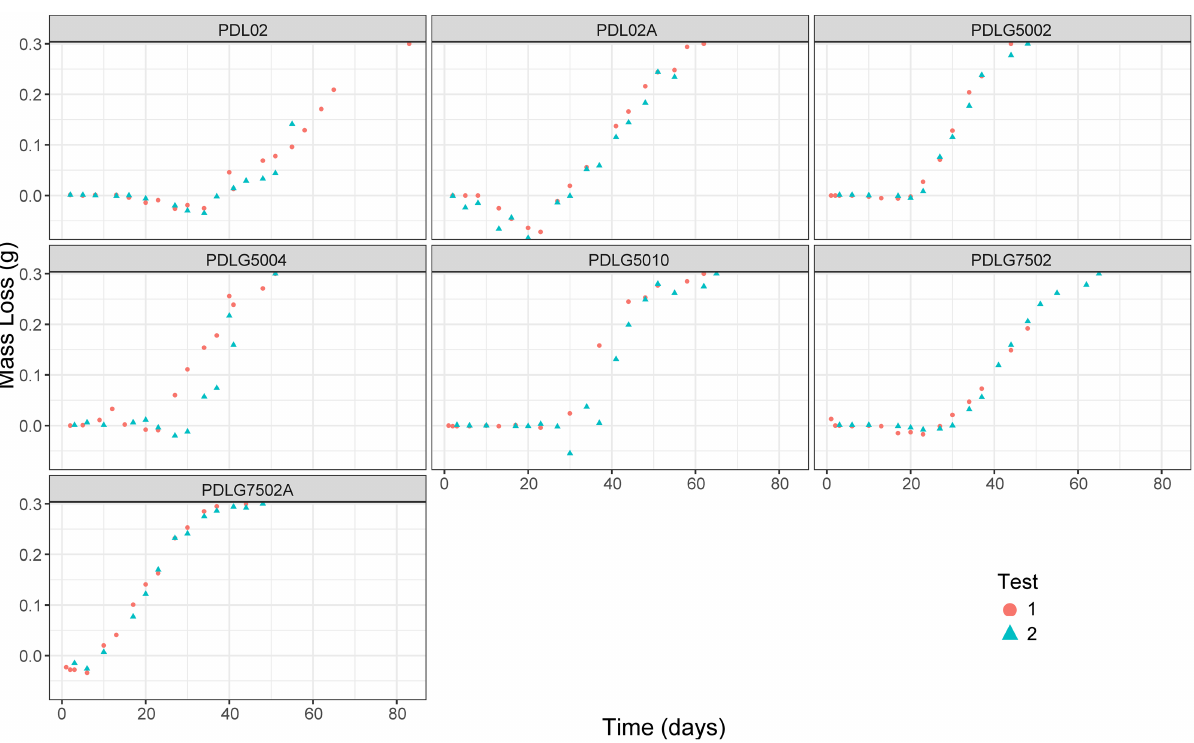
Fig 2. The two degradation paths (two replicates per polymer have been performed in laboratory) corresponding to each polymer are shown. They are obtained by experimental procedures in lab.